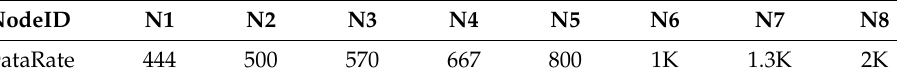
Table 2. Data rate of each node (bps).